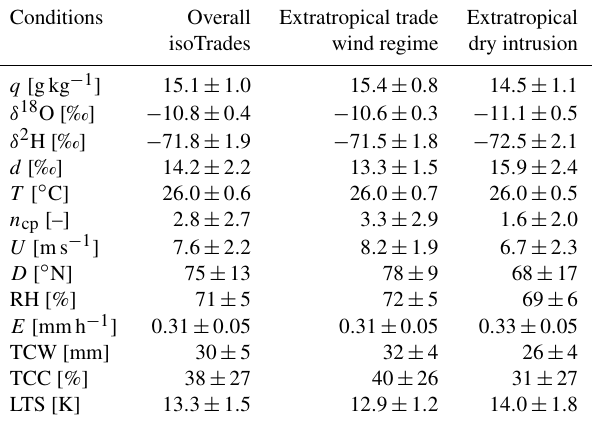
Table 3. Campaign mean local conditions at the BCO as well as conditions associated with the extratropical trade wind and dry in- trusion flow regimes, respectively, based on measurements (first nine variables) and ERA5 data. The p value of a Wilcoxon rank- sum test for the significance of the difference between the two regimes’ distributions is < 0 . 01 except for T ; q is the specific humidity, T the air temperature, P the rain rate, n cp the num- ber of cold pools within a 12h time period centred at the respec- tive hourly time steps, U the wind speed, D the wind direction and RH the relative humidity measured at BCO. The evaporation rate ( E ), the total column water (TCW), the total cloud cover (TCC) and the lower-tropospheric stability (LTS = θ 700hPa − θ 1000hPa ) are extracted from ERA5 and averaged over a 2 ◦ × 2 ◦ box around BCO (13–15 ◦ N and 58–60 ◦ W) to provide regionally averaged values of these variables. Note that the results do not change substantially if the variables are interpolated to the position of the